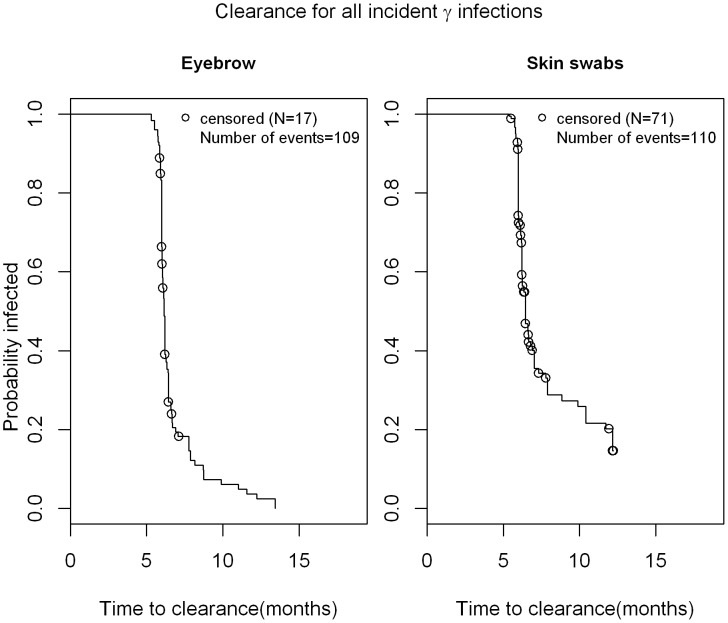
Time to clearance of γ-HPV infection in normal skin swabs and eyebrow hairs of men.Kaplan Meier estimate for time to clearance for all type-specific incident infections a study participant (n = 209) had before their last visit with a valid sample. The 'last observation carried forward' approach was taken when counting time to clearance (e.g. for 0 1 NA 0 pattern of HPV positivity, the NA was treated as '1' and the time was counted towards the time to clearance).